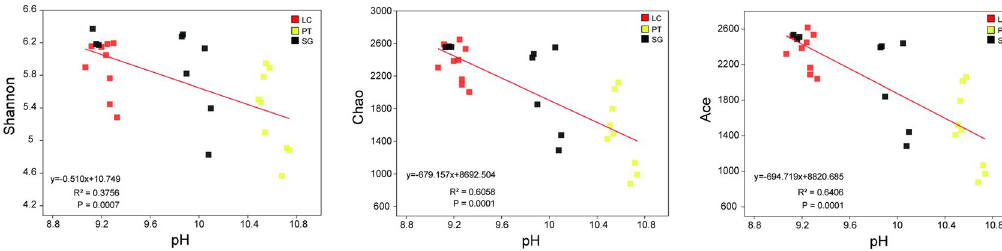
Fig 5. Linear regression analysis between the alpha diversity indices and pH. LC, Leymus chinensis (Trin.) Tzvel.; PT, Puccinellia tenuiflora (Griseb.) Scribn. et Merr.; SG, Suaeda glauca (Bunge) Bunge.